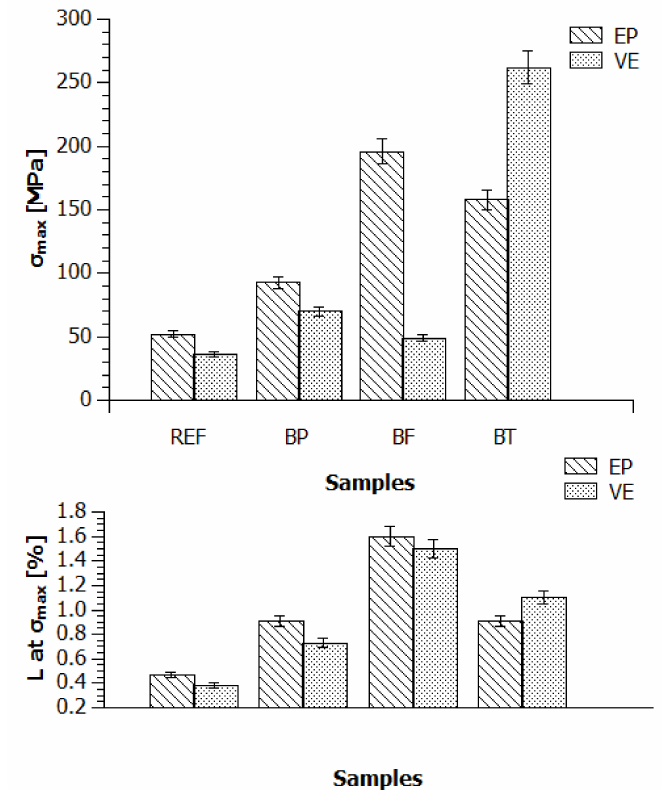
Figure 11. Relation between σ max and corresponding elongation (L at σ max ) in bending strength test for composites EP and VE reinforced with basalt powder (BP), basalt fibre (BF) and basalt textile (BT) for measurements at − 20 ◦